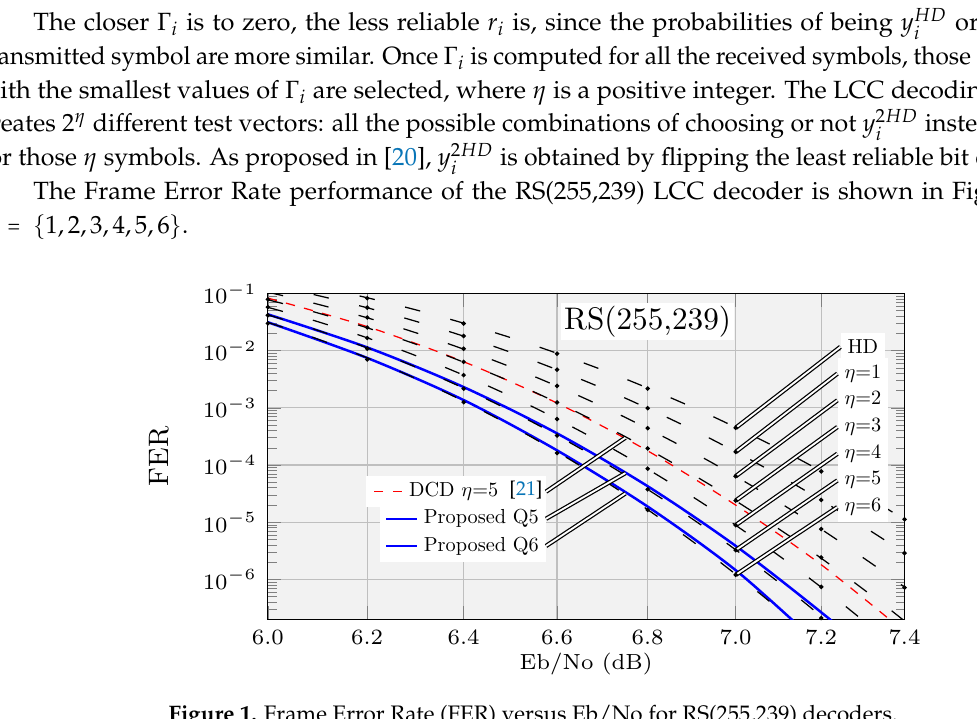
Figure 1. Frame Error Rate (FER) versus Eb/No for RS(255,239)